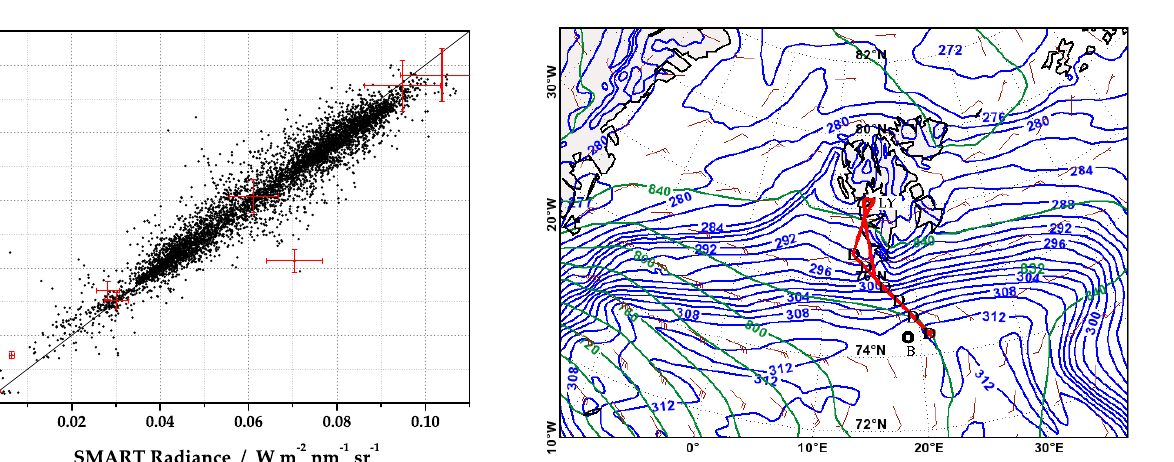
Fig. 3. Comparison of the 870nm radiance from the SMART- Albedometer and from the SMART spot of the AisaEAGLE for the flight on 17 May 2010. The radiometric uncertainty (8% for AisaEAGLE, 9% for SMART-Albedometer) are marked with red crosses at exemplary data points.